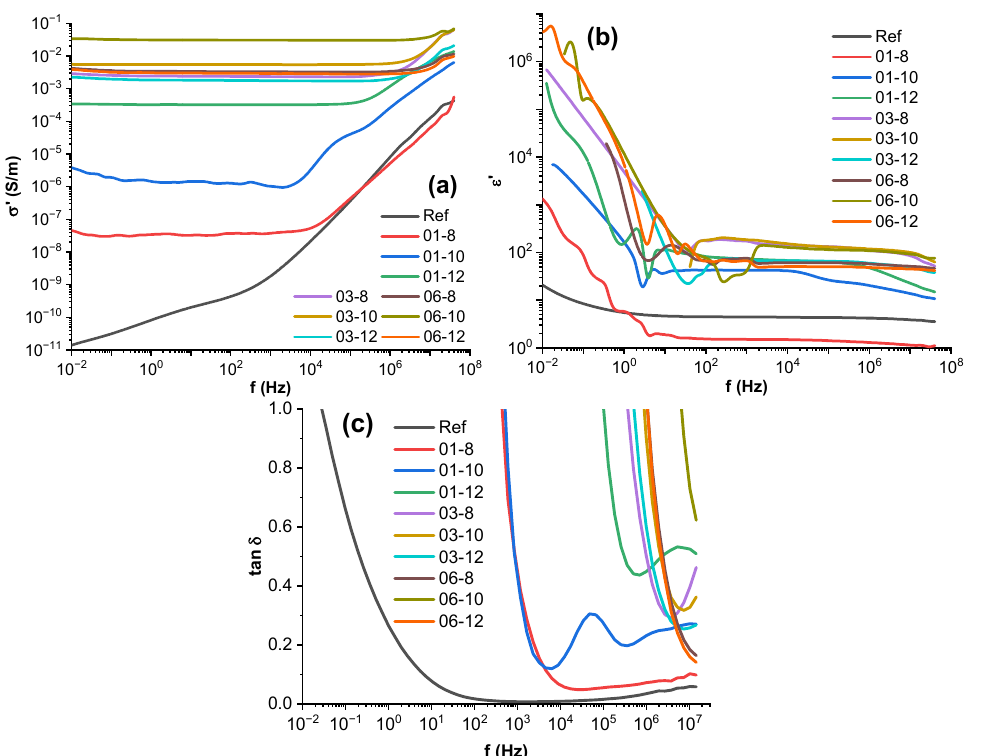
Figure 5. The broadband dielectric spectroscopy ( a ) AC conductivity, ( b ) real part of permittivity, and ( c ) loss tangent of permittivity of the PBS hybrid nanocomposites.